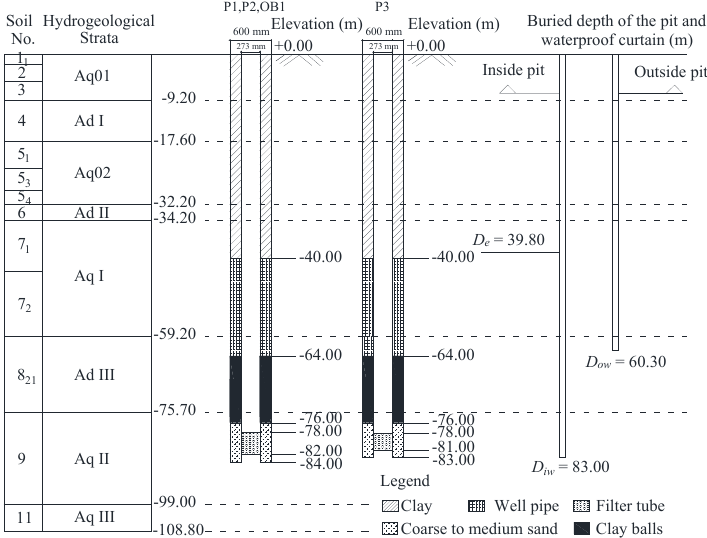
Figure 3. Profile of pumping and observation wells (recreated based on [35]).